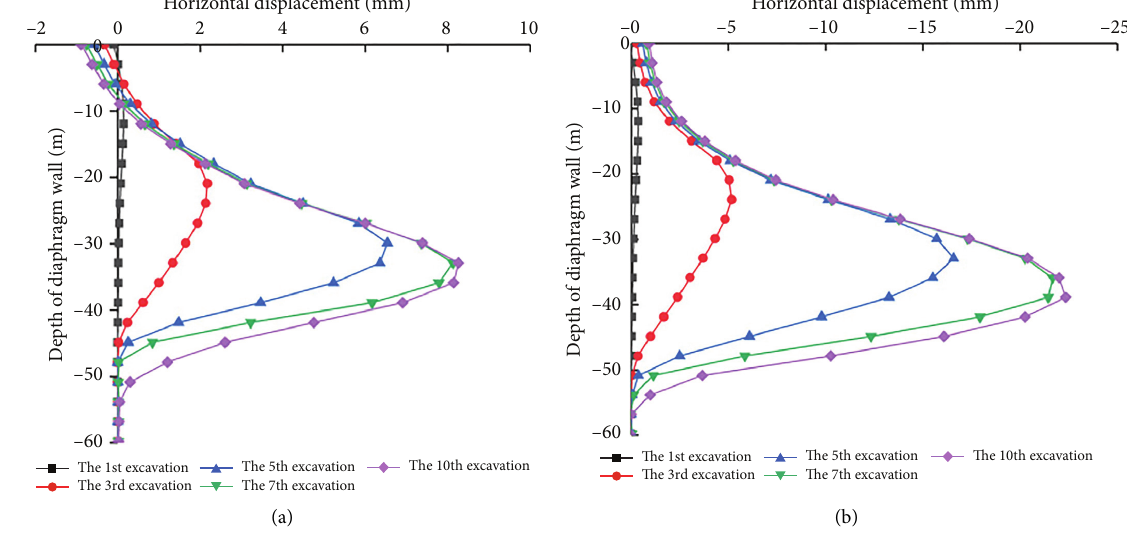
Figure 9: The horizontal displacement curve of the diaphragm wall. (a) West wall. (b) East Table 4: Summary of the corresponding depth of the maximum horizontal displacement of the ground connecting wall. Working procedure